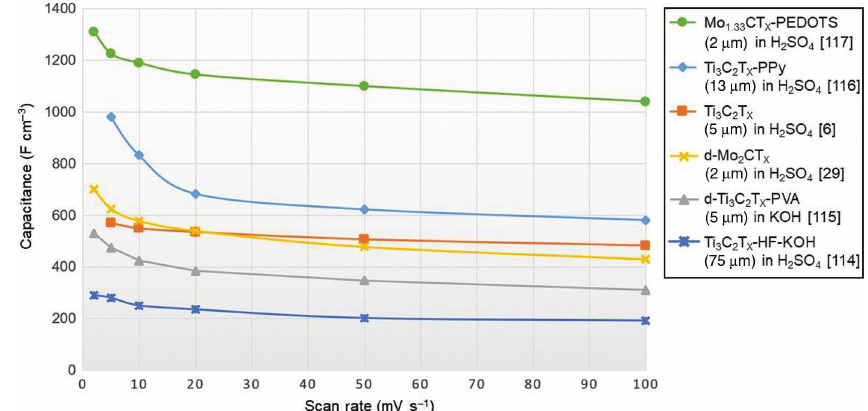
Figure 10: Comparison of rate performances of selected MXene electrodes.